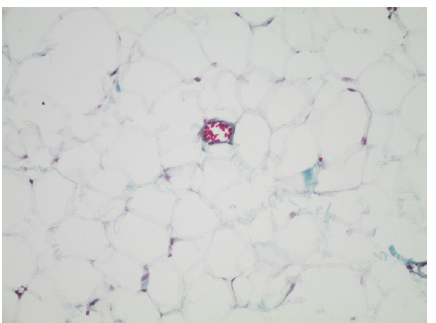
Figure4:Histologicalexaminationofthebuccallipomaontheright side by Goldner’s Trichrome